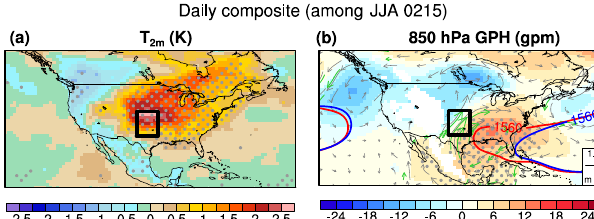
Figure 11. Daily composites of the anomalies of (a) T 2m (K) and (b) 850hPa geopotential height (gpm) and horizontal wind vec- tors (ms − 1 ; grey) from ERA-Interim averaged over dusty days in JJA from 2002 to 2015. Blue and red contours in panel (b) denote 1560gpm in the climatology (2002–2015) and during dusty days, respectively. Areas significant at the 95% confidence level are dot- ted. Wind vectors significant at the 95% confidence level are plotted in green. Black boxes denote the CGP